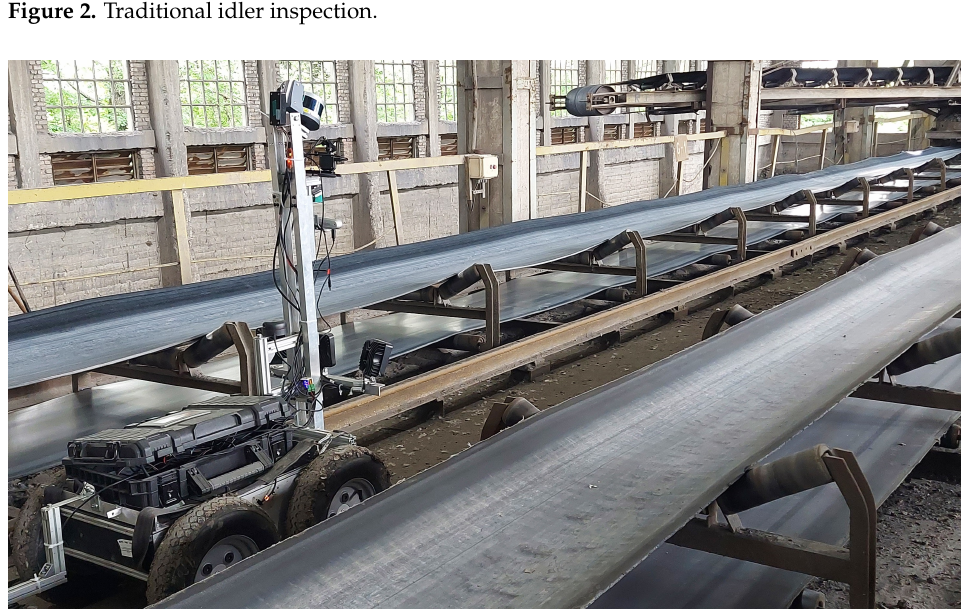
Figure 3. View of the robot during